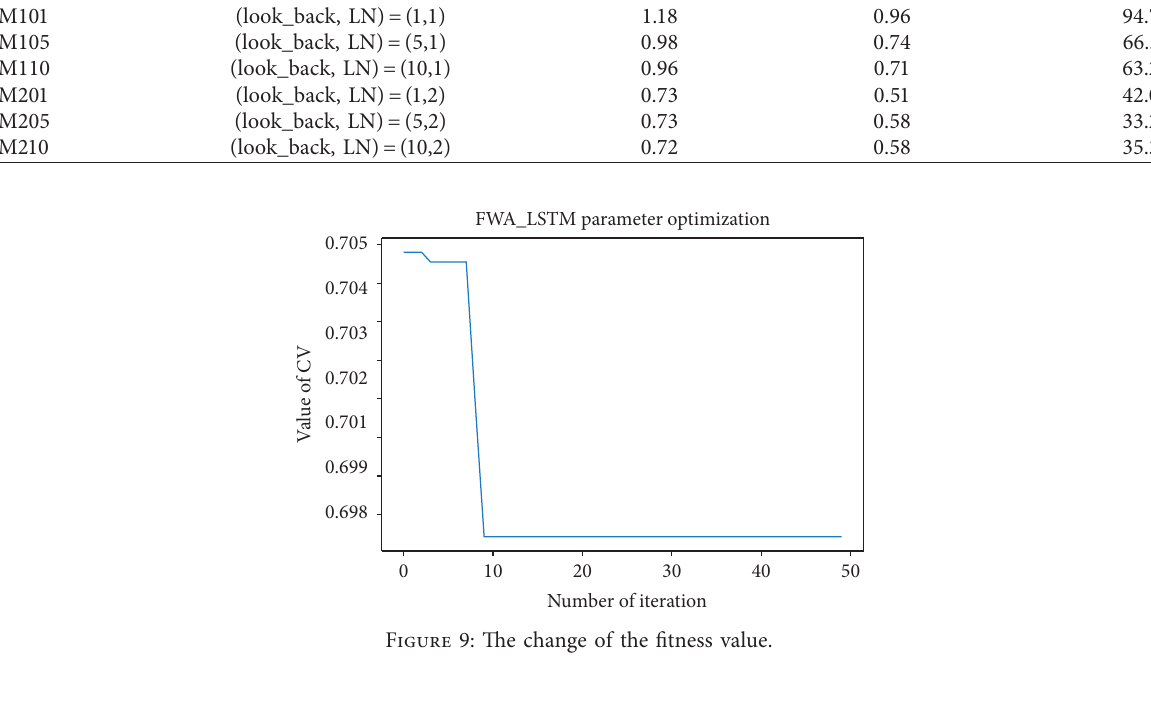
Table 1: Errors of LSTM-based wind speed prediction models under different parameter combinations. Model